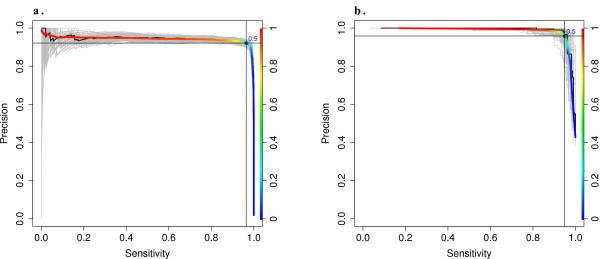
Theoretical Performance of the Regression Models. (a) The Atlas-SNP2 model is evaluated on a subset of the training data, which requires a minimum total depth of 10 base-pairs. (b) The Atlas-Indel2 model is evaluated on a subset of the training data that requires at least 2 variant reads (a default heuristic filter). To estimate the effectiveness of the regression models and test for overfitting, a series of cross-validation tests were performed by repeatedly sampling half of the training data to be used to train the model, and then evaluating the model on the remaining data. This process was repeated 100 times, with each result plotted as a gray line. The average of all these lines is plotted as a bold, color-coded line. The color indicates the p cutoff which returns the given performance at that point. The suite's default cutoff of 0.5 is marked. The actual model evaluated on the full set is plotted as a black line, but is mostly covered by the average line.